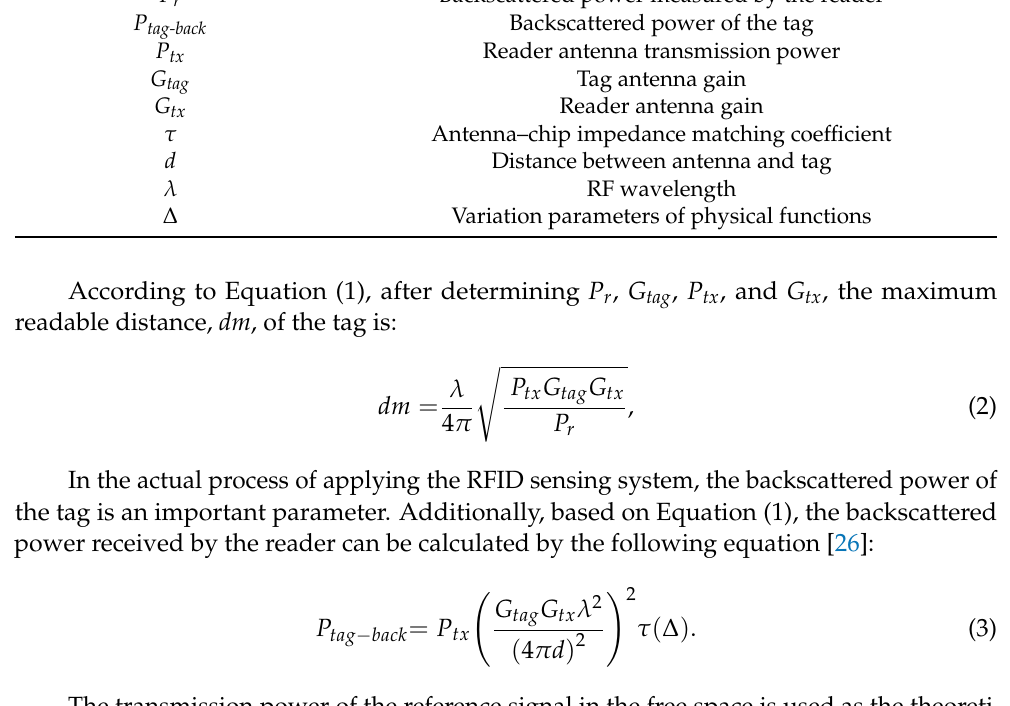
Table 1. Parameters related to differential backscatter power in UHF RFID sensing. Symbol Description P r Backscattered power measured by the reader P tag-back Backscattered power of the tag P tx Reader antenna transmission power G tag Tag antenna gain G tx Reader antenna gain τ Antenna–chip impedance matching coefficient d Distance between antenna and tag λ RF wavelength ∆ Variation parameters of physical